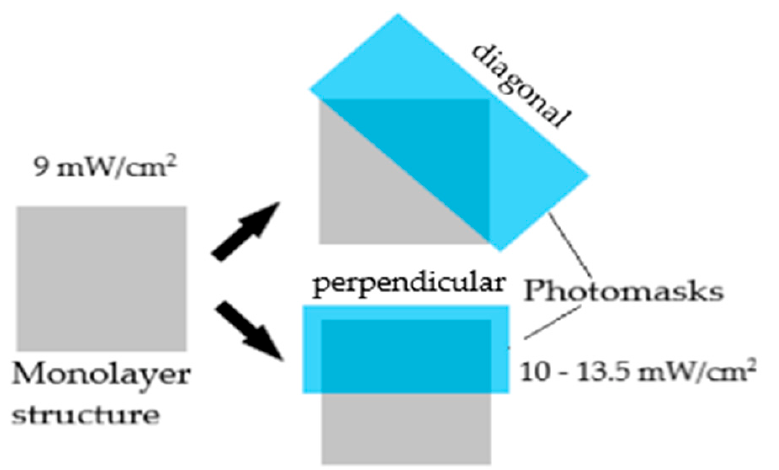
Figure 1. UV-curing of monolayer structures containing regions with different crosslinking degrees.